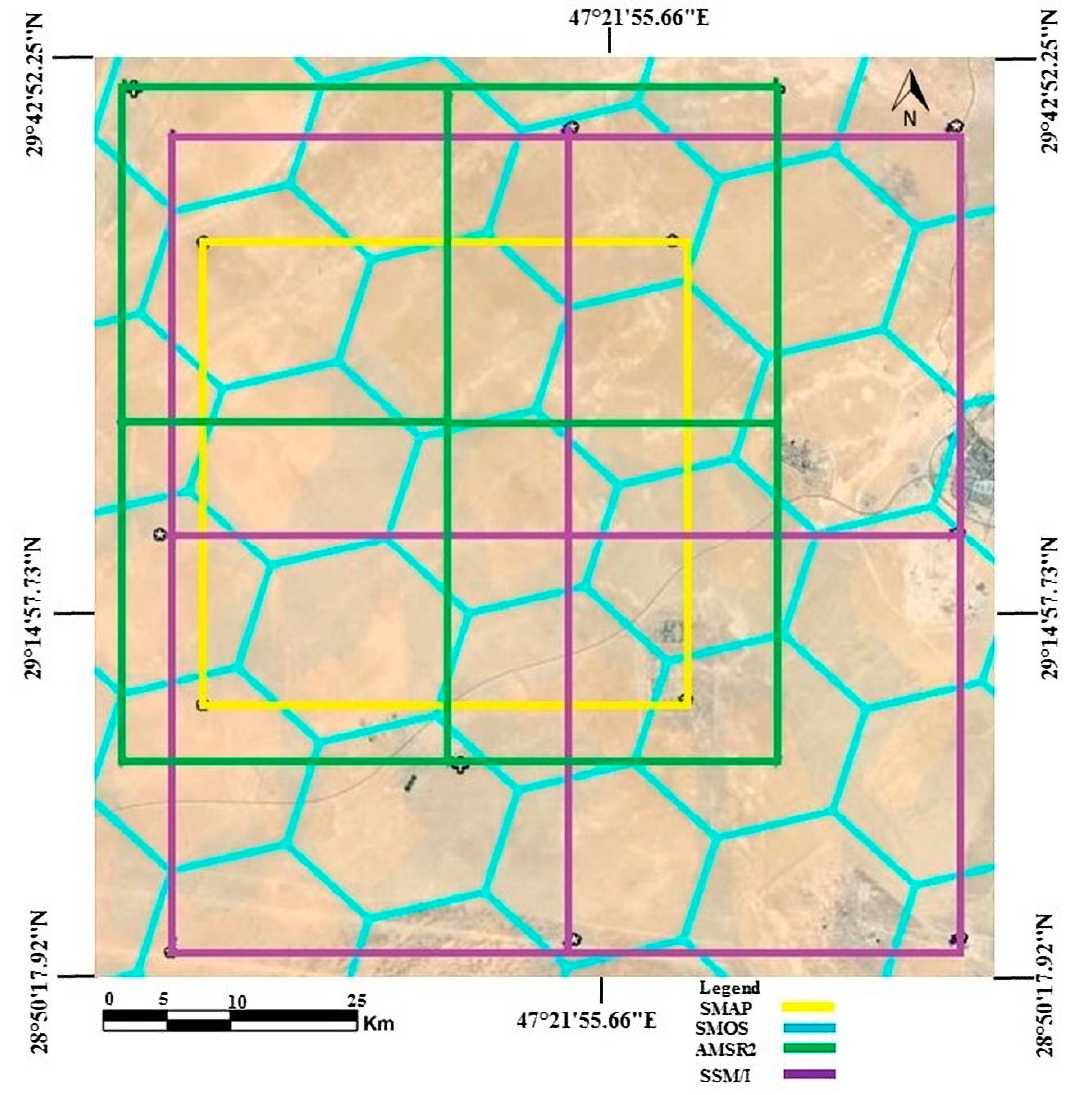
ff erent satellite resolutions over the test Figure 3. Different satellite resolutions over the test site. Figure 3. Di